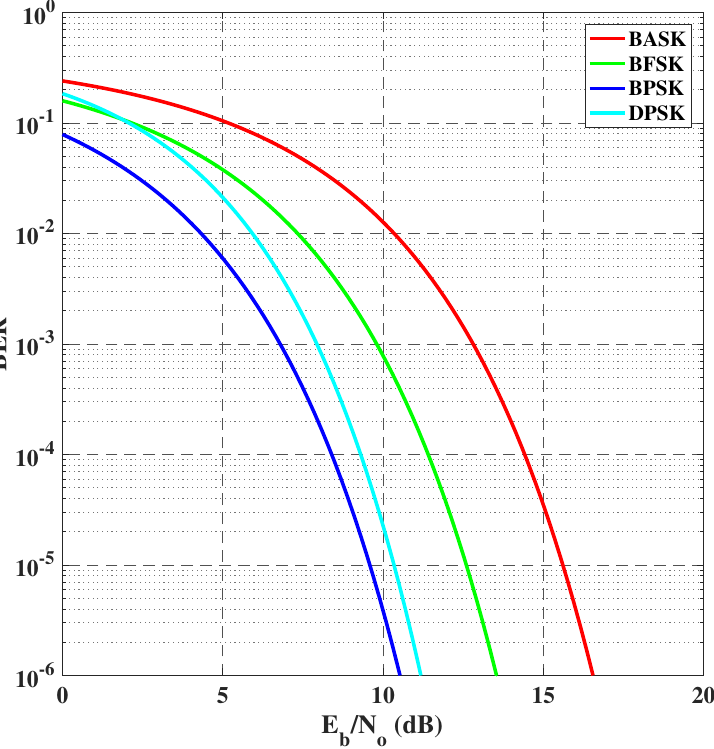
Figure 2. BER vs. SNR ( E b / N o ) for binary modulation schemes: comparison by applying theoretical equations shown in the Ref. [32]. The graph was obtained by using the M ATLAB code reported in [33], supposing a AWGN channel and a unitary energy-per-bit, while the bit signal length is 10 5